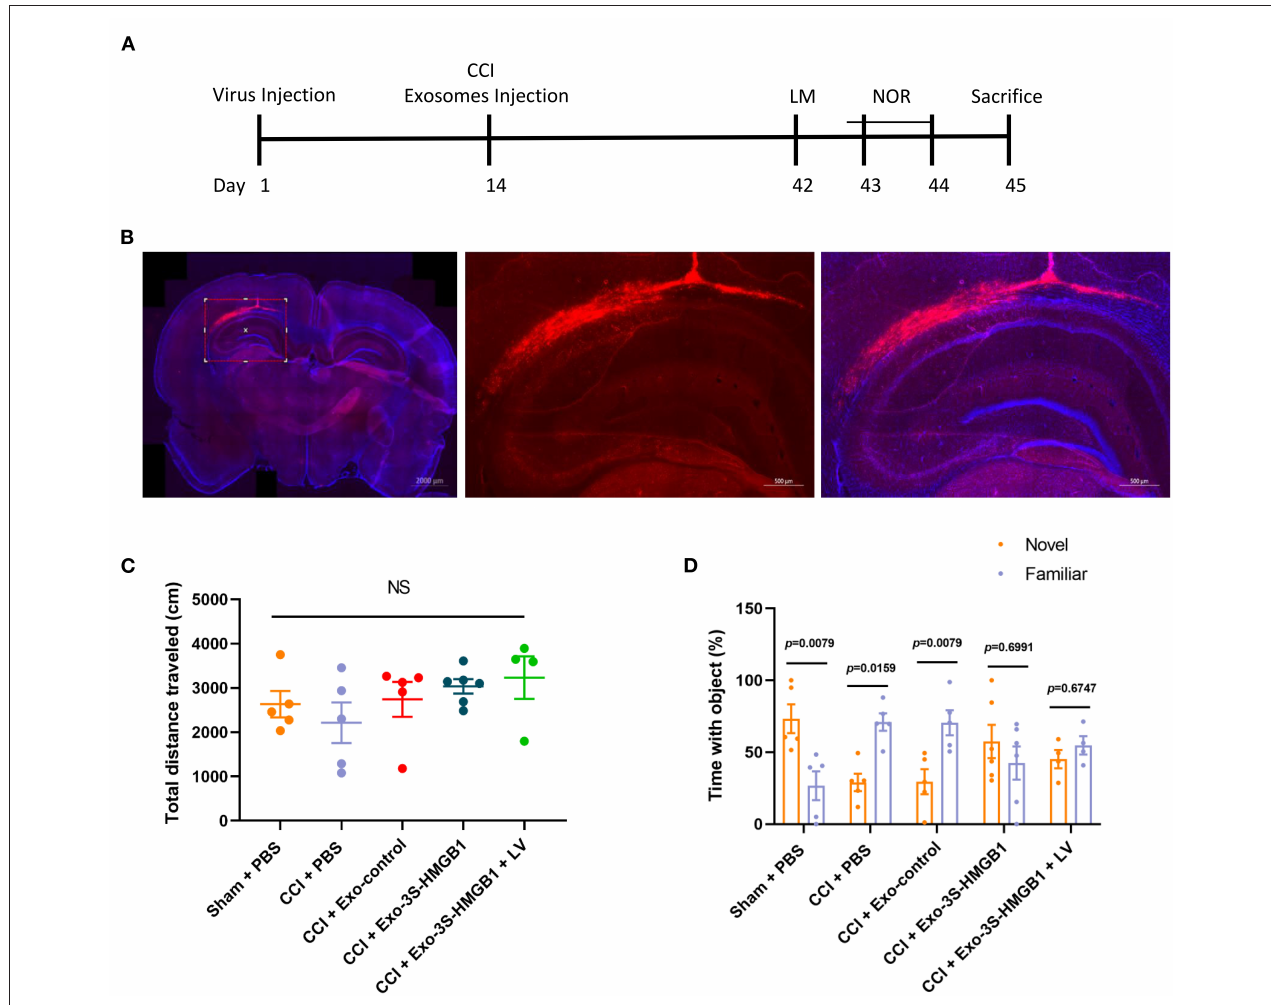
FIGURE 6 | LV-shSH3RF2 attenuated the effect of Exo-3S-HMGB1 to improve the recovery of memory function in CCI. (A) The experimental timeline for the neurobehavioral testing. (B) Representative electron microscopy images of brain sections from rats intervened with LV-shSH3RF2. (C) No differences were observed in the open field test. (D) Exploration times and discrimination indices were calculated in NOR test. Mean ± SEM, NS: no